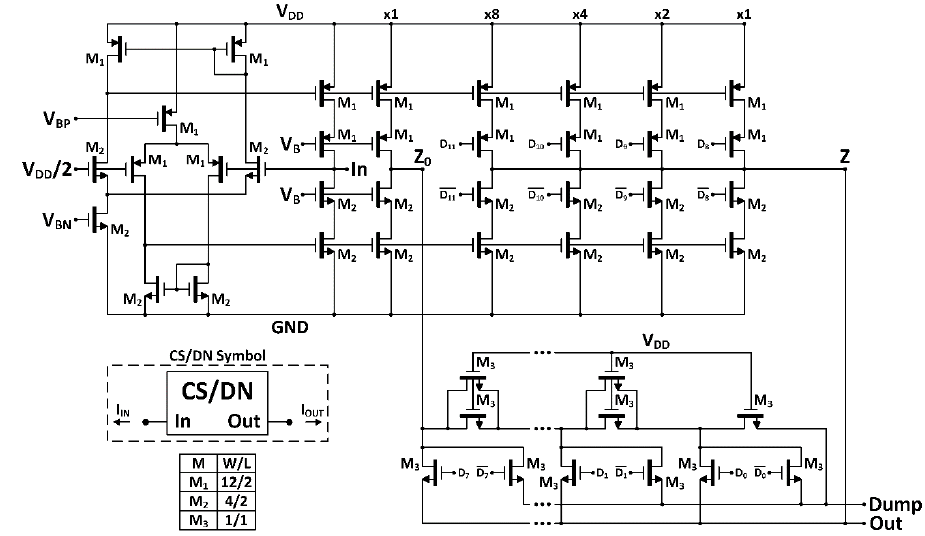
Figure 4. CS/DN schematic topology and transistor sizes in µm.